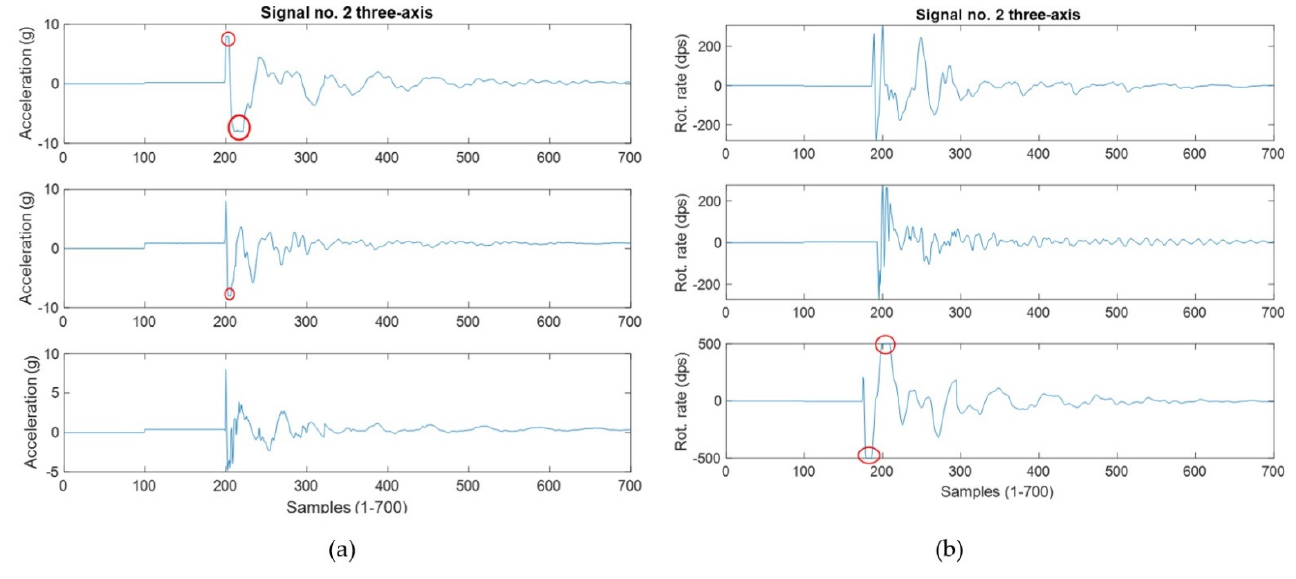
Figure 7. This figure shows the saturation point of 8 g for the accelerometer ( a ) on all 3-axes (X, Y, Z) circled in red and the gyroscope ( b ).